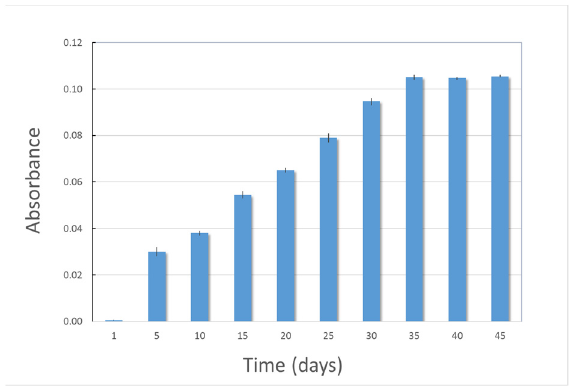
Figure 2. Time variation of absorbance in ethanol maceration.